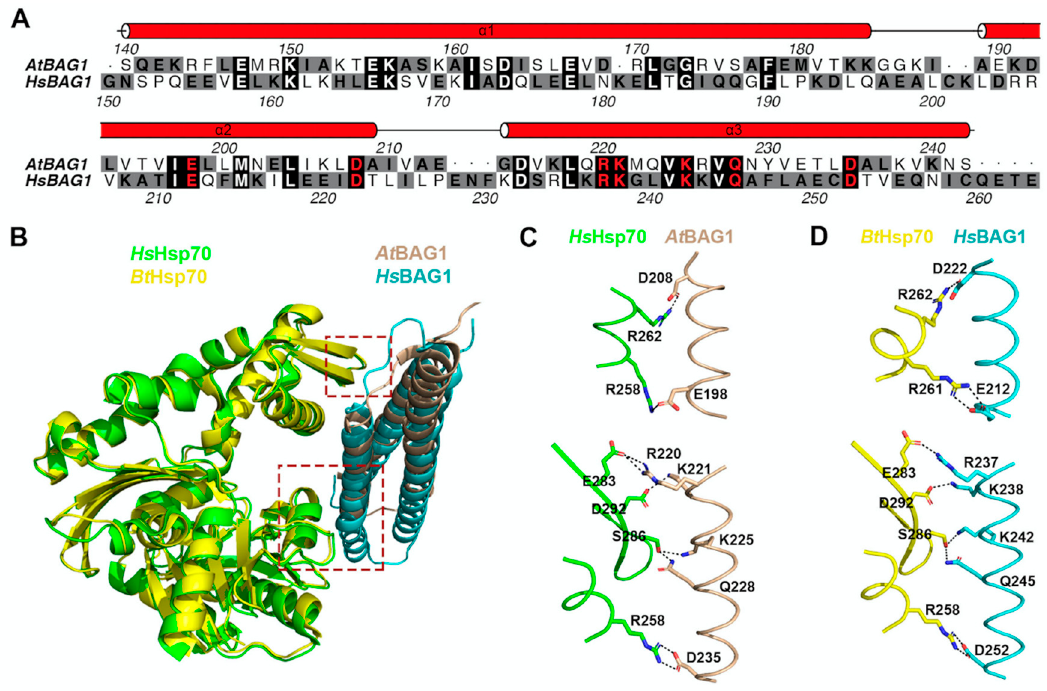
Figure 4. Conserved interactions with Hsp70 for Arabidopsis BAG1 or human BAG1. ( A ) Sequence alignment of BAG domain from Arabidopsis thaliana and Homo sapiens BAG1 protein. Secondary structure and residue numbers were numbered according to Arabidopsis BAG1. Conserved residues forming the interaction surface with the Hsc70 are highlighted in red. ( B ) Structure comparison of complex of Hsp70 with BAG domain from Arabidopsis (PDB code 4HWI) and humans (PDB code 1HX1). ( C ) Enlarged schematic diagram of the interactions between BAG domain of Arabidopsis BAG1 and Human Hsp70 from B. ( D ) Enlarged schematic diagram of the interactions between BAG domain of human BAG1 and Bos taurus Hsp70 from B.